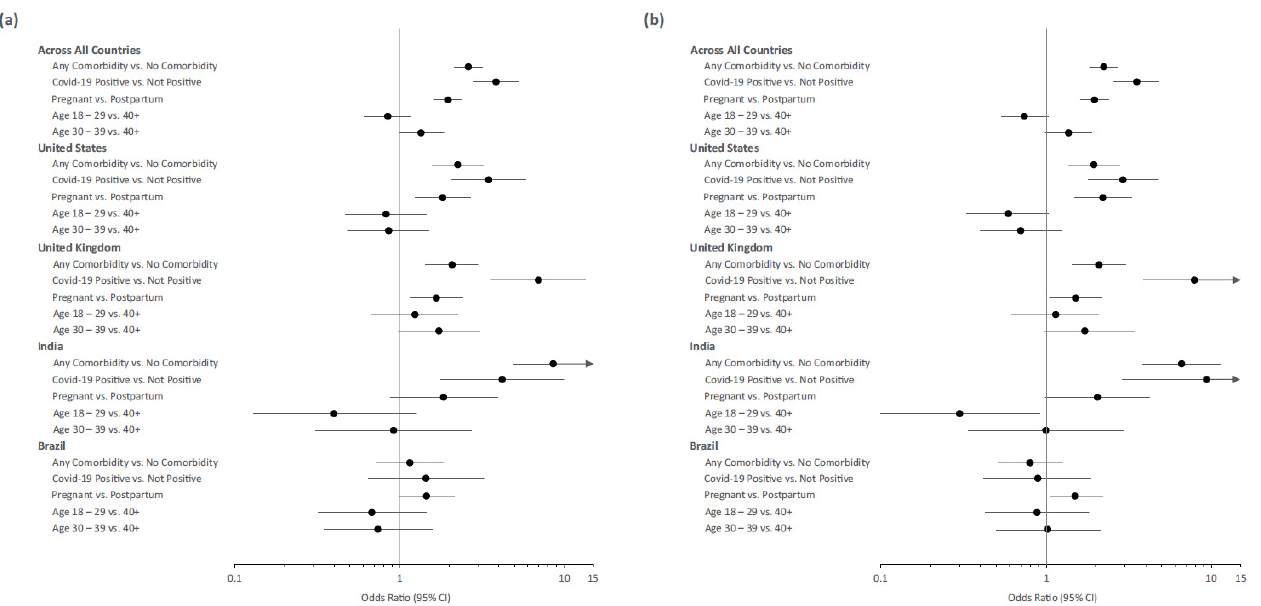
Figure 3. Univariate (unadjusted) Odds Ratio (95% CI) by country and across countries for potential prognostic factors for openness to oneself ( a ) and one’s children/other family members ( b ) receiving a COVID-19 vaccine (vs. Neutral/Unsure and Not Open) among pregnant and postpartum women. Odds ratios greater than one indicate that the respondents in the comparison group were more open than the reference group to vaccine acceptability.